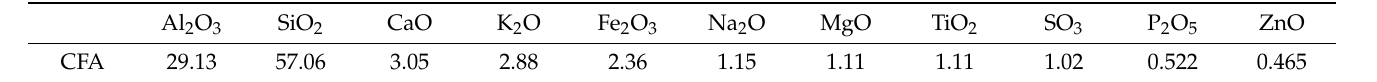
Figure 1. XRD pattern of the CFA. Table 1. Chemical composition of coal fly ash determined by XRF Table 1. Chemical composition of coal fly ash determined by XRF ( w t.%).